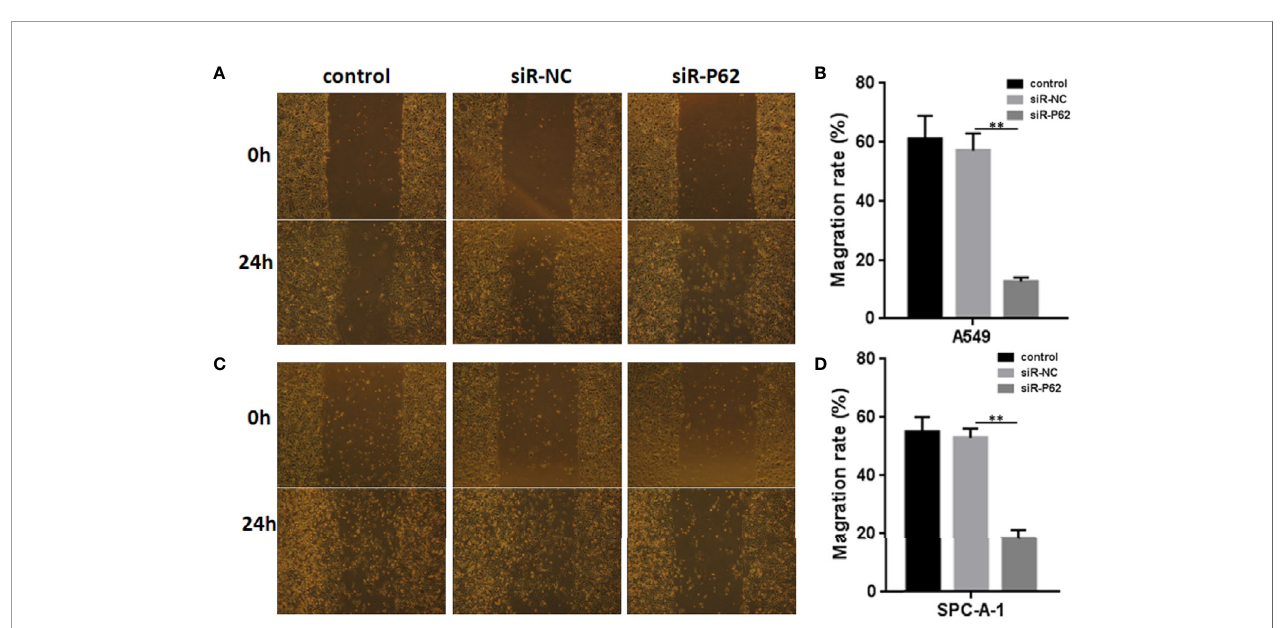
FIGURE 4 | p62 downregulation inhibits the migration of A549 and SPC-A-1 cells. (A) Migration of A549 cells with different p62 expression. (B) p62 downregulation inhibited the migration of A549 cells. (C) Migration of SPC-A-1 cells with different p62 expression. (D) p62 downregulation inhibited the migration of SPC-A-1 cells. control, untreated A549 or SPC-A-1 cells; siR-p62, small interfering p62 RNA transfected cells; siR-NC, siR-p62 scrambled control. **P < 0.01